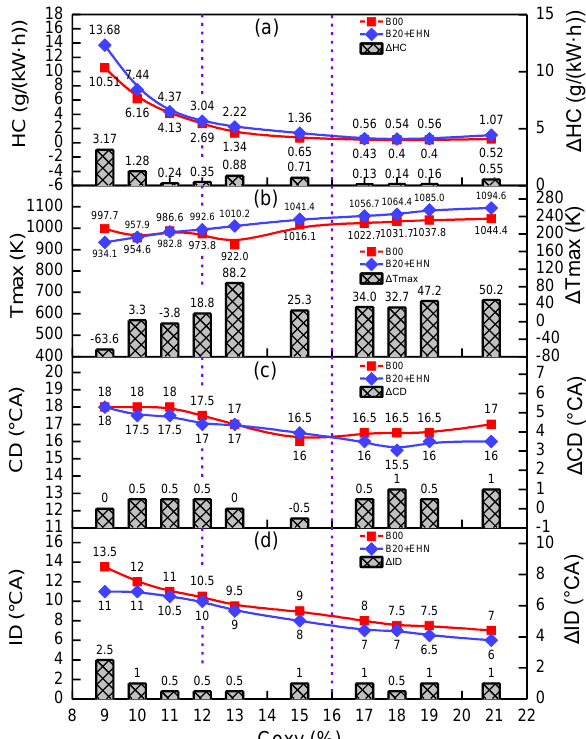
Figure 5. HC emissions and the difference ( a ), maximum in-cylinder temperatures and the difference ( b ), combustion durations and the difference ( c ), and ignition delay periods and the difference ( d ) for B00 and B20 + EHN fuels.